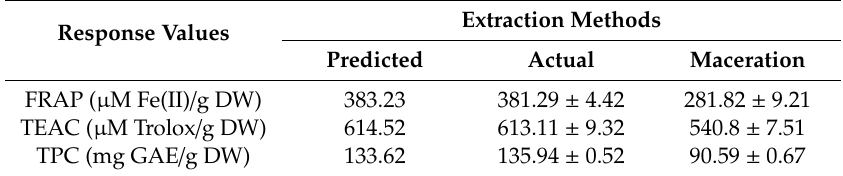
Table 6. Comparison of the response values of actual experiment, fitted model prediction and maceration method.